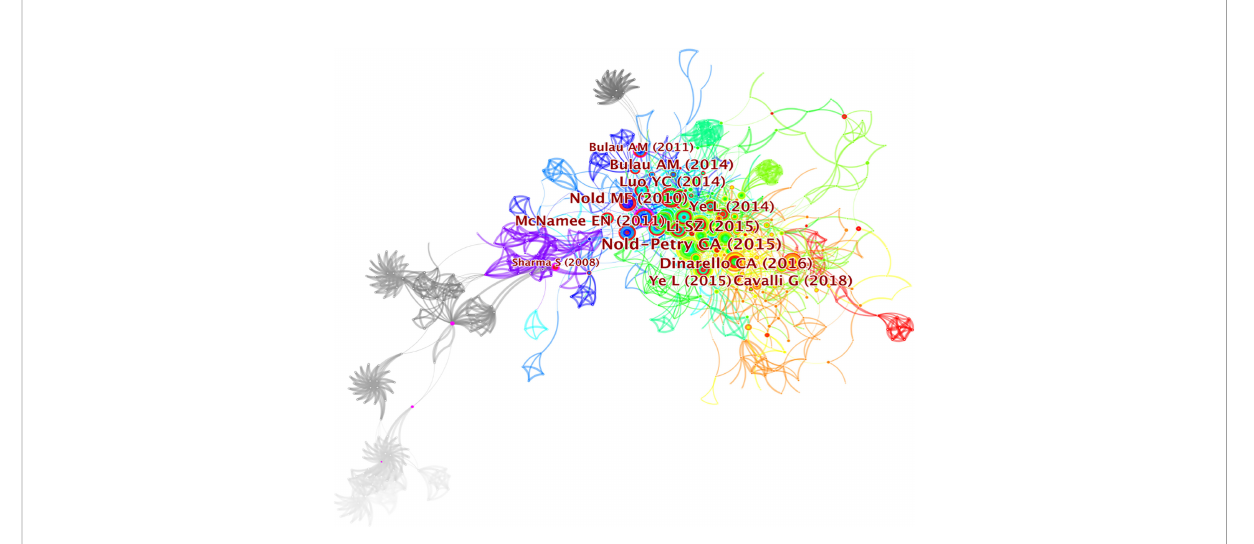
FIGURE 5 The visualization of co-cited references on IL-37 research.